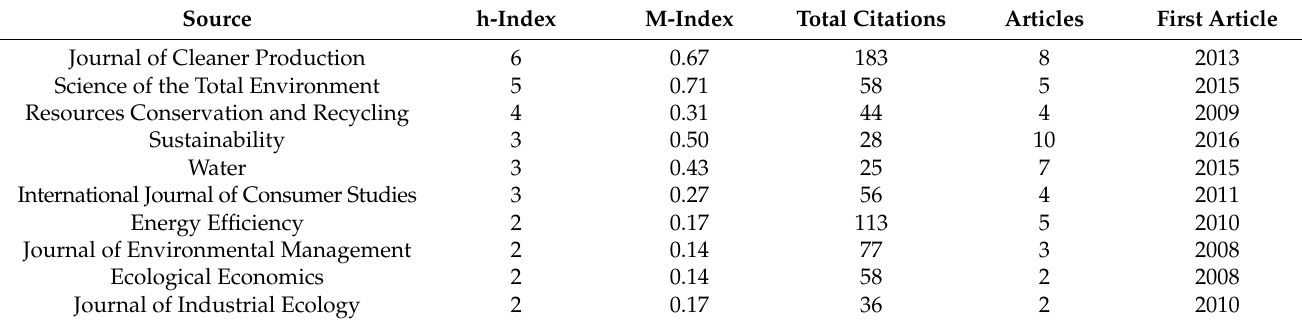
Table 2. Source’s local